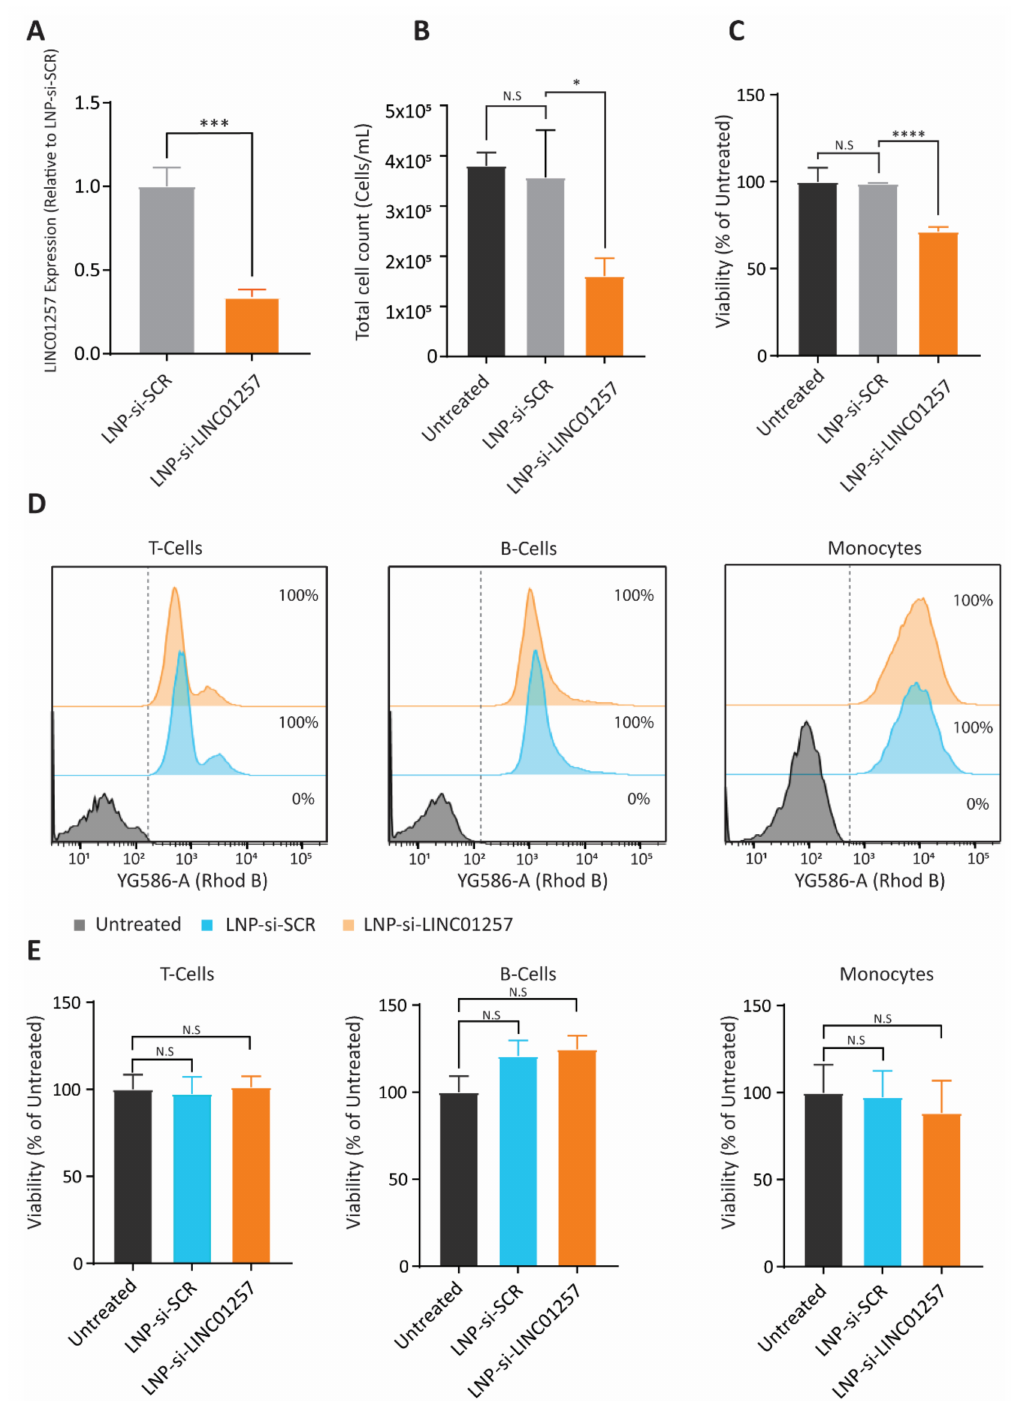
Figure 6. LNP-si-LINC01257 inhibits growth of Kasumi-1 cells but not healthy PBMCs. ( A ) RT-qPCR analysis of LINC01257 expression in Kasumi-1 cells treated with LNP-si-SCR or LNP-si-LINC01257. *** = p < 0.001. ( B ) Cell counts of Kasumi-1 cells 48 h following LNP-si-SCR or LNP-si-LINC01257 treatment. * = p < 0.05, N.S = no significance. ( C ) Percentage of viable Kasumi-1 cells following treatment with LNP-si-SCR or LNP-si-LINC01257. Untreated cells were used as a normalized control. **** = p < 0.0001, N.S = no significance. ( D ) Flow cytometry histograms of LNP-si-SCR and LNP-si-LINC01257 uptake, indicated by Rhodamine B (Rhod B) signal, in T-cell, B-cell and monocyte populations from healthy donor PBMCs following 48 h treatment. ( E ) Viability of T-cell, B-cell and Monocytes following 48 h treatment with LNP-si-SCR or LNP-si-LINC01257. Untreated cells were used as a normalized control. N.S = no significance. n =